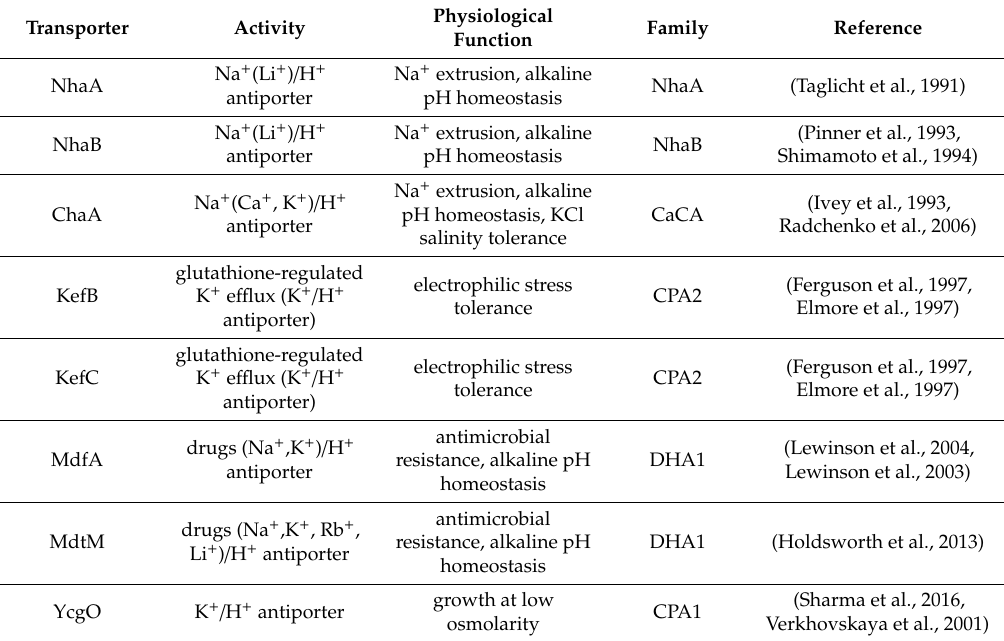
Figure 2. Localization of CPAs (cation / proton antiporters) in Escherichia coli ( A ), cyanobacteria ( B ) and Arabidopsis thaliana ( C ). Table 1. CPAs in Escherichia